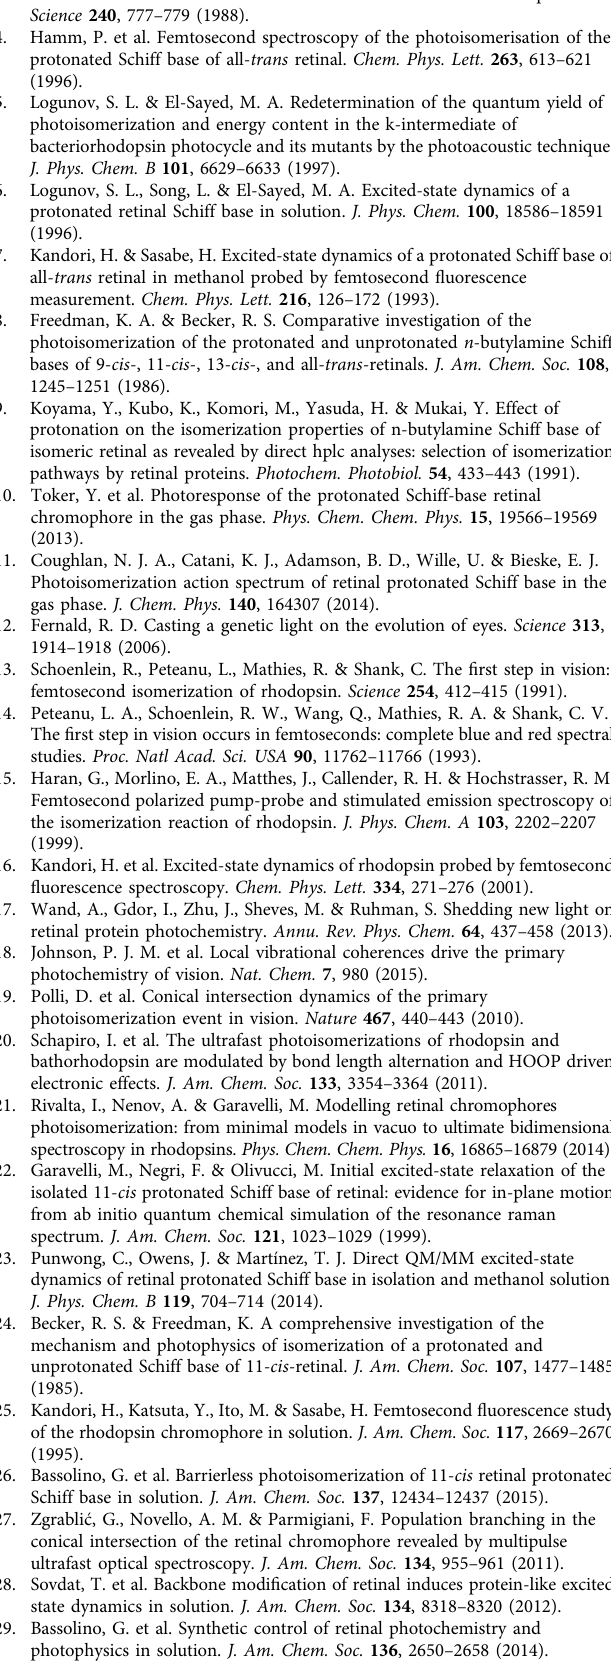
structure calculations. Excited-state lifetimes of all- trans RPSB are calculated using transition state theory as an inverse of a sum of rate constants that refer to rotation about three double bonds. We assume the same thermal population of vibrational levels in S 1 as in S 0 , following excitation that is close to the adiabatic transition in RPSB. An excess of vibrational energy gained upon excitation is therefore con- sidered to be small compared to an average vibrational energy of the chromophore ions equilibrated in the ground state prior to excitation. Partition functions for the reaction modes are calculated based on the exact eigenvalues found as numerical solutions to the one-dimensional Schrödinger equation using the calculated XMCQDPT2 potentials that hinder rotation about double bonds in S 1 . Data availability The authors declare that the data supporting the fi ndings of this study are available from the corresponding author upon reasonable request.